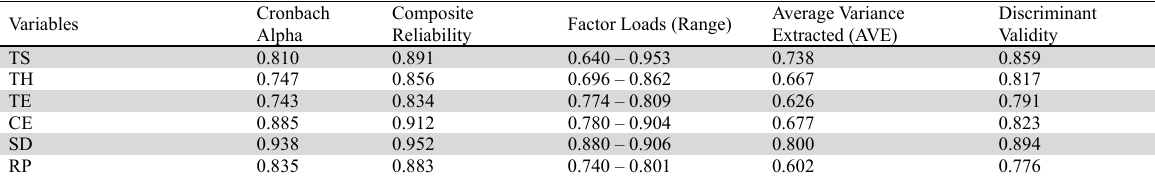
Model Measurement Analysis Results